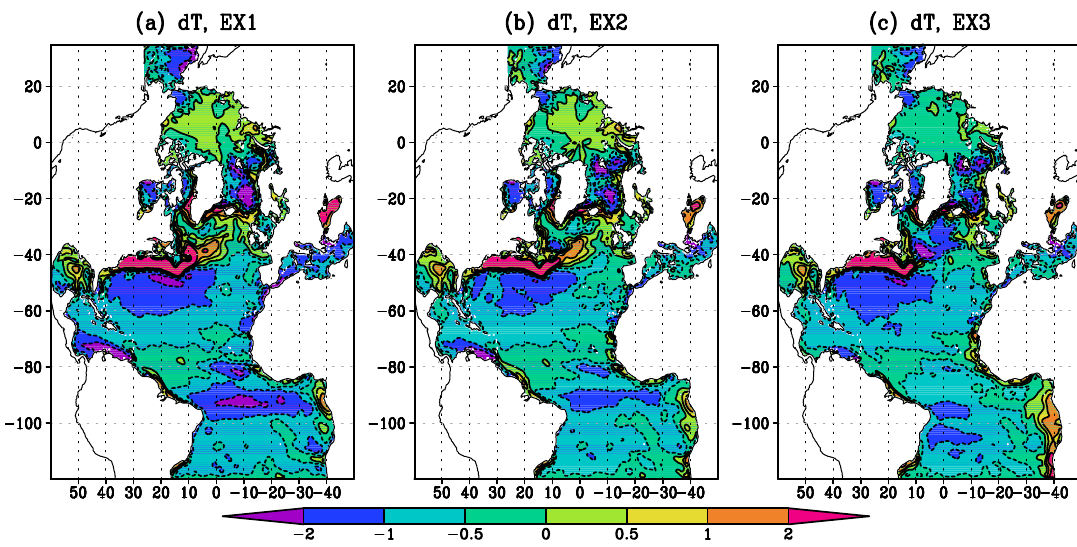
Figure 1. Average for 1963–2009 temperature deviations (in ◦ C) in the 0–30 m layer from climatic data [41] in the experiments EX1 ( a ), EX2 ( α Cl = 0.9 ) ( b ) and EX3 ( c ). Coordinates of the